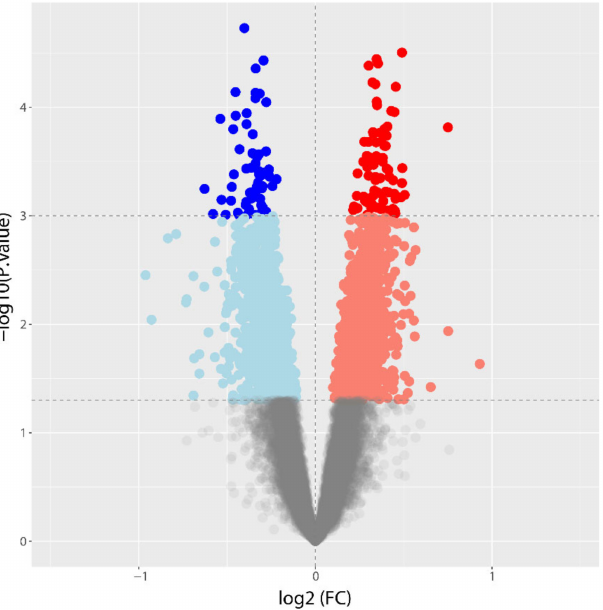
Figure 1. Volcano plot of differential gene expression analysis of CAD vs. noCAD patients. Red and blue dots represent genes significantly overexpressed or decreased in CAD patients, respectively ( p < 0.001). Pink and light blue dots highlight genes with higher or lower expression in CAD vs. noCAD patients, respectively, at a nominal p -value < 0.05. Grey dots represent genes with no difference in expression between the two